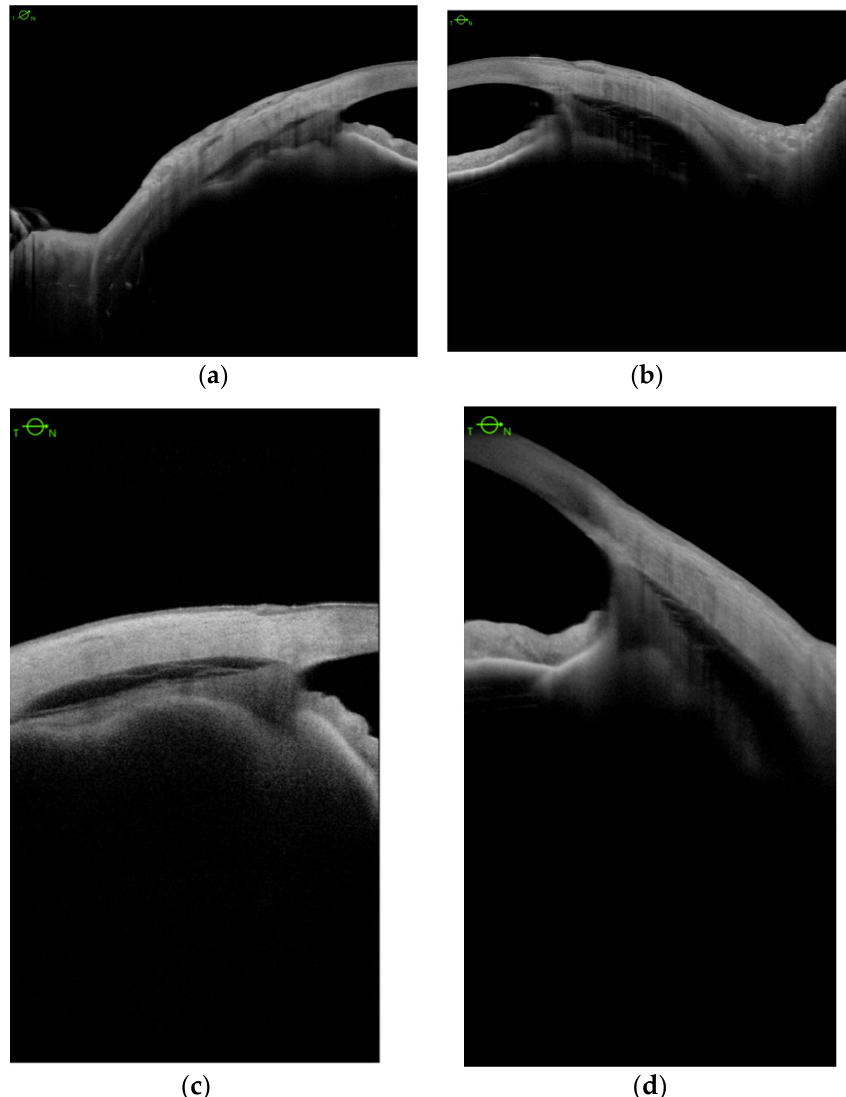
Figure 3. Anterior segment swept-source OCT demonstrates ciliary body detachment preoperatively ( a , b ) and postoperatively ( c , d ).